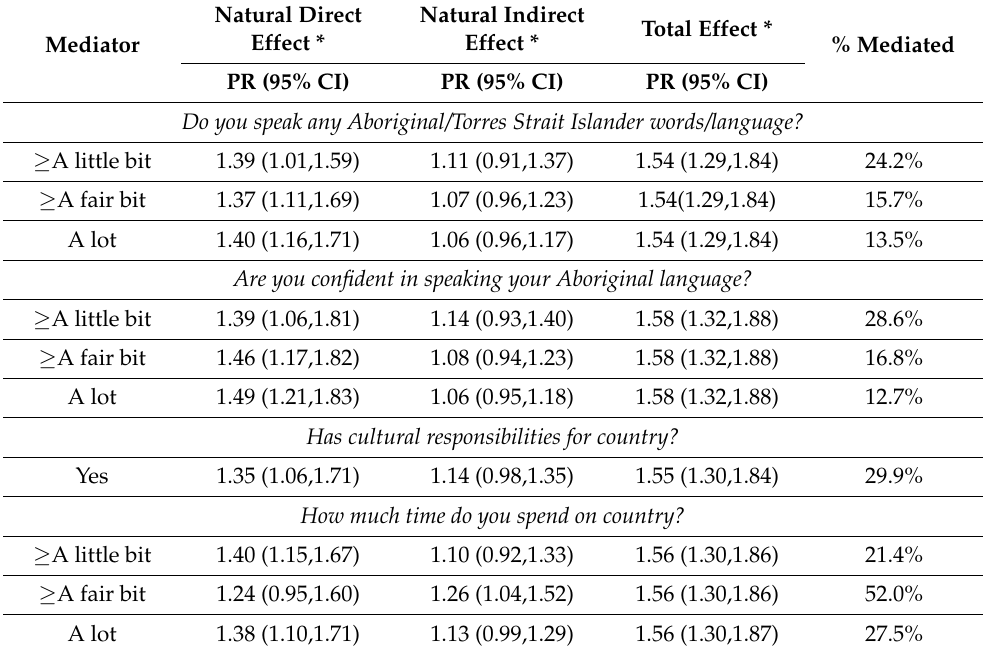
Table 6. Mediation analysis of cultural variables on relationship between Ranger status and high family